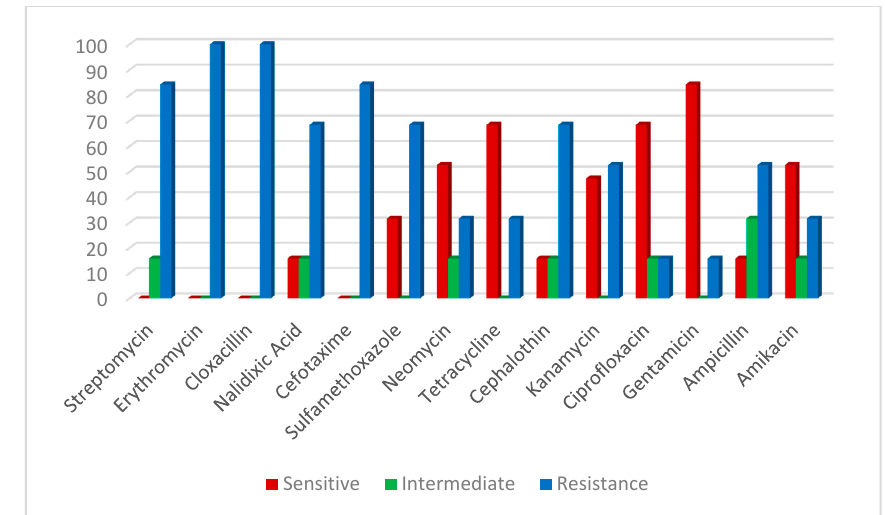
Figure 6. Antibiotic susceptibility of A. hydrophila . Table 3. Antibiotics resistance profile and MAR index of V. parahaemolyticus isolated from Nile tilapia ( n * = 29).